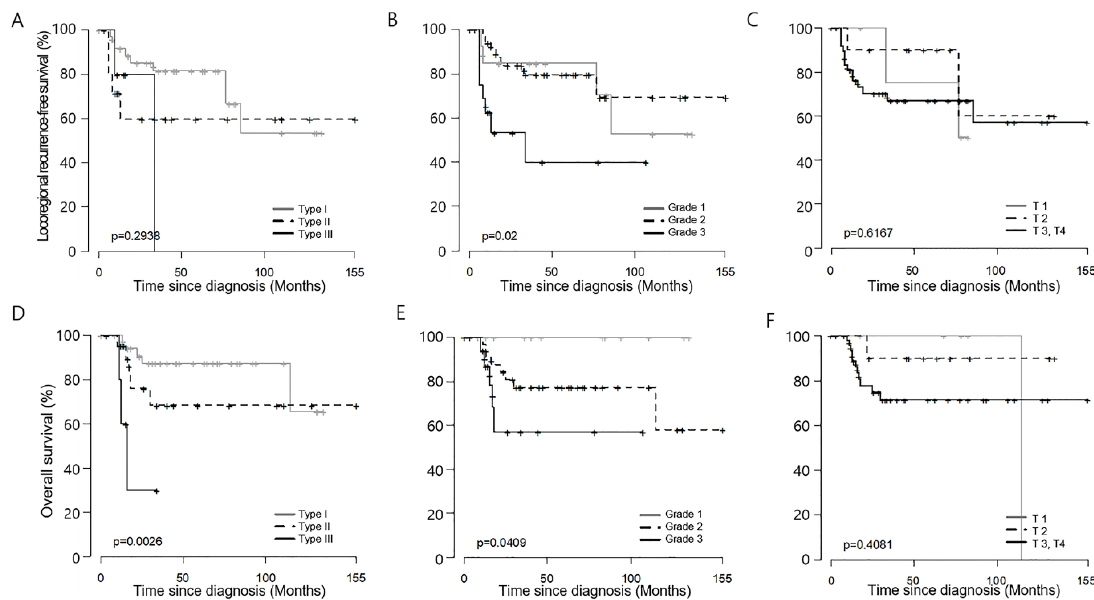
Figure 2. Kaplan–Meier curves of locoregional recurrence ( A – C ) and death ( D – F ) based on ( A , D ) Imaging type, ( B , E ) Imaging–Histology combined stage, and ( C , F ) T-stage.